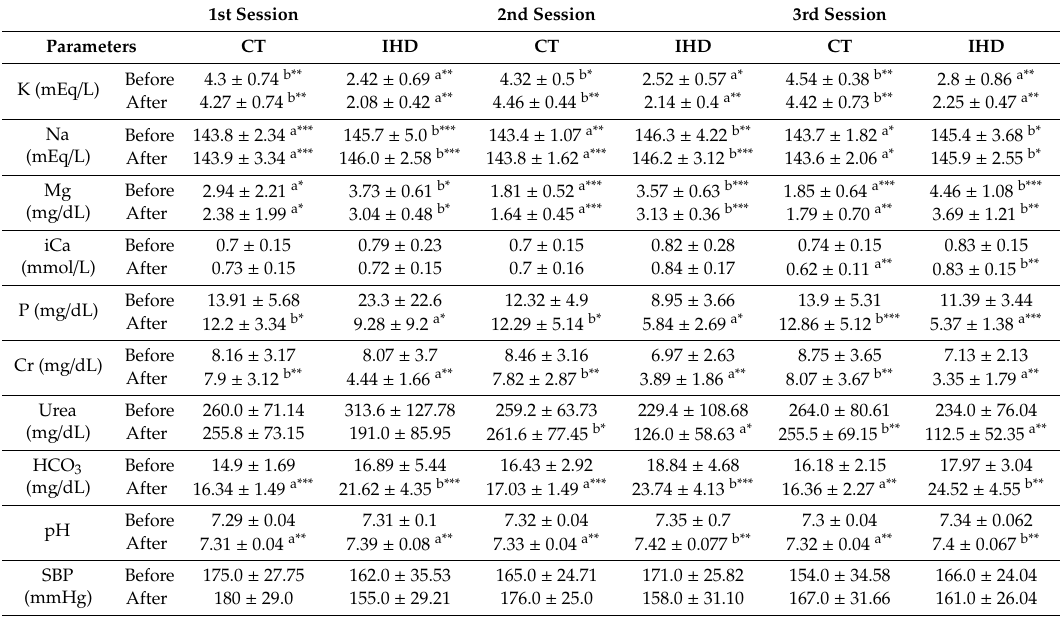
Table 4. Means and standard deviations for the laboratory test results and systolic blood pressure (SBP) in dogs with IRIS CKD Stage 4 undergoing CT and IHD, before and after the treatment sessions. 1st Session 2nd